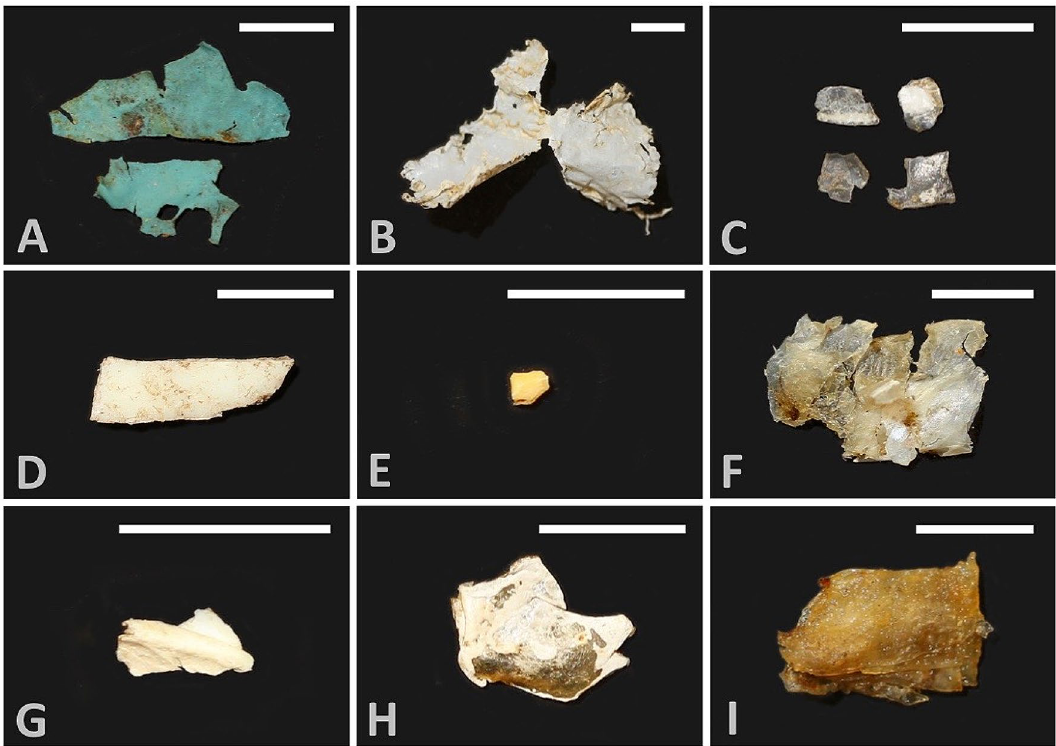
Figure 1. Plastic ( A – E ; LACM 190543, 190527, 190550, 190547, 190529) and plastic-resembling organic material ( F – I ; LACM 190564, 190560, 190550, 190564) ingested by Red-eared Sliders, Trachemys scripta elegans ,